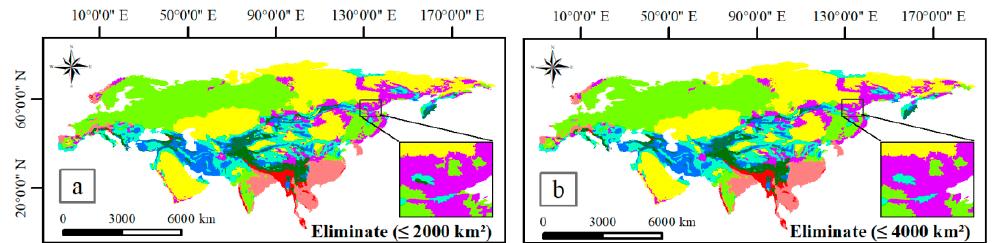
Figure 8. Small-patch elimination of nine-classification patches: ( a ) threshold of 2000 km 2 ; ( b ) threshold of 4000 km 2